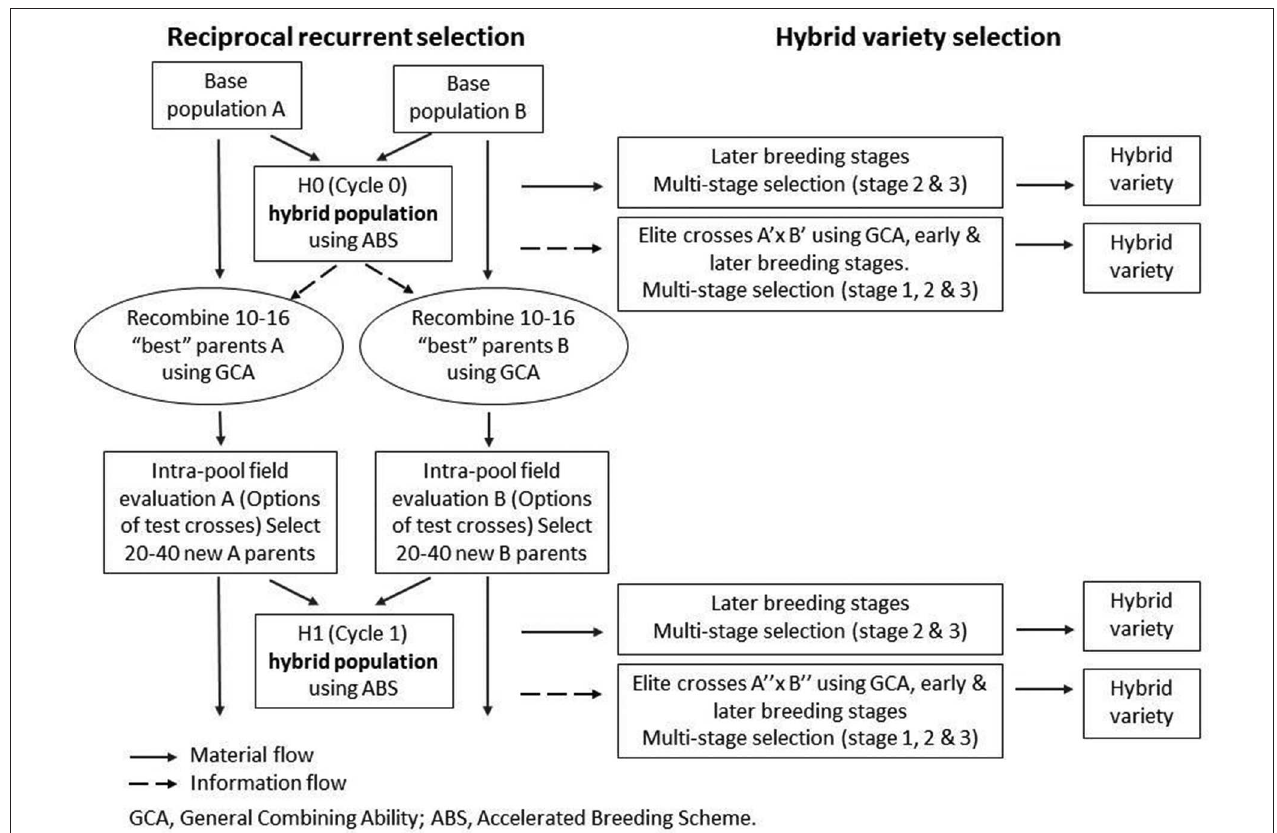
FIGURE 2 | Population hybrid breeding – a heterosis exploiting breeding scheme for clonally propagated crops.